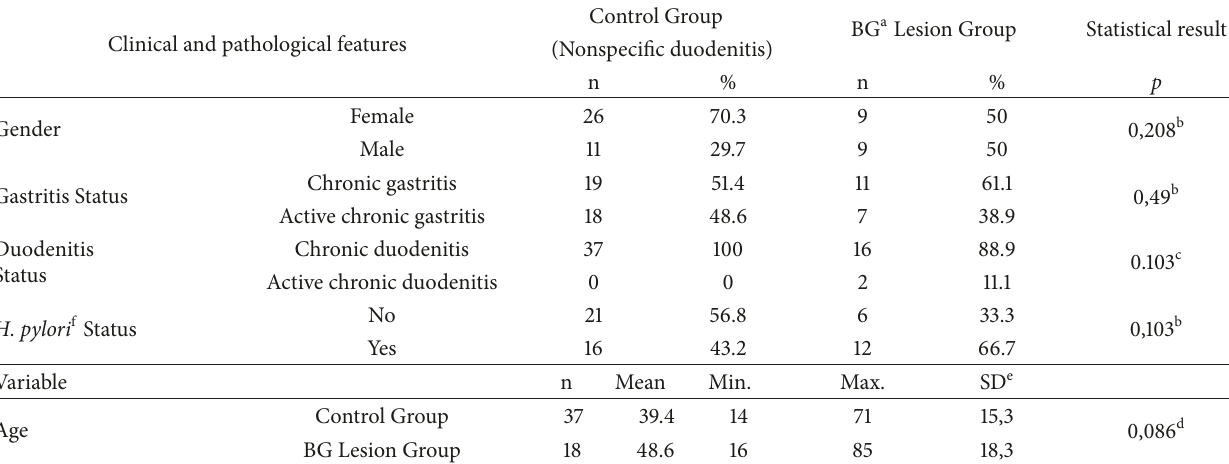
Table 1: Distribution of clinical and pathological features. Clinical and pathological features